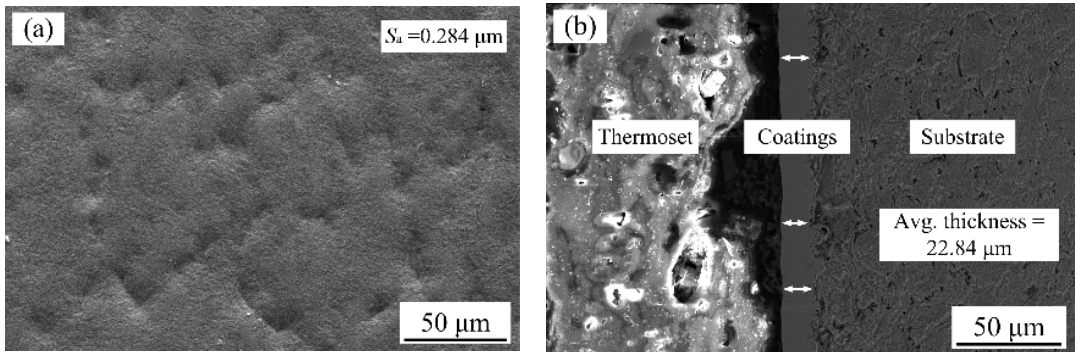
Figure 1. ( a ) Surface morphology and ( b ) cross-section images of binary nanocomposite coatings deposited using jet electrodeposition.